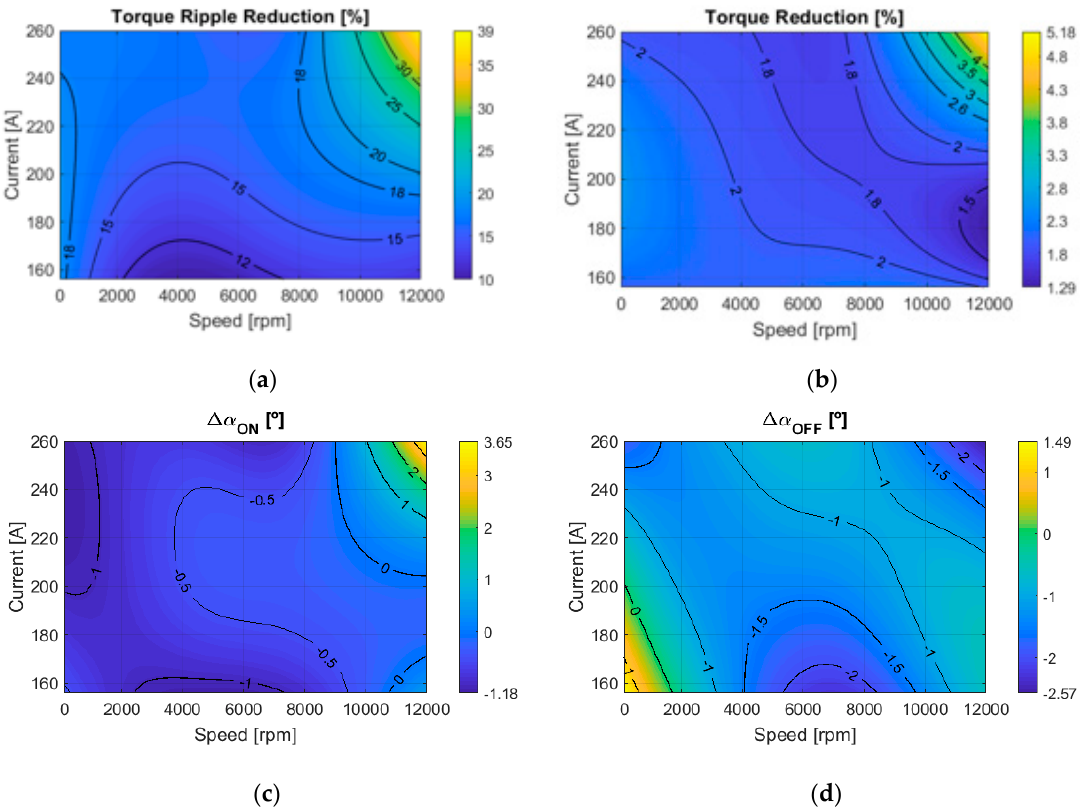
Figure 17. ( a ) Torque ripple reduction evolution as a function of the speed and current; ( b ) average torque reduction evolution as a function of the speed and current; ( c ) differential switching on angle evolution as a function of speed and current; ( d ) differential switching off angle evolution as a function of the speed and current.